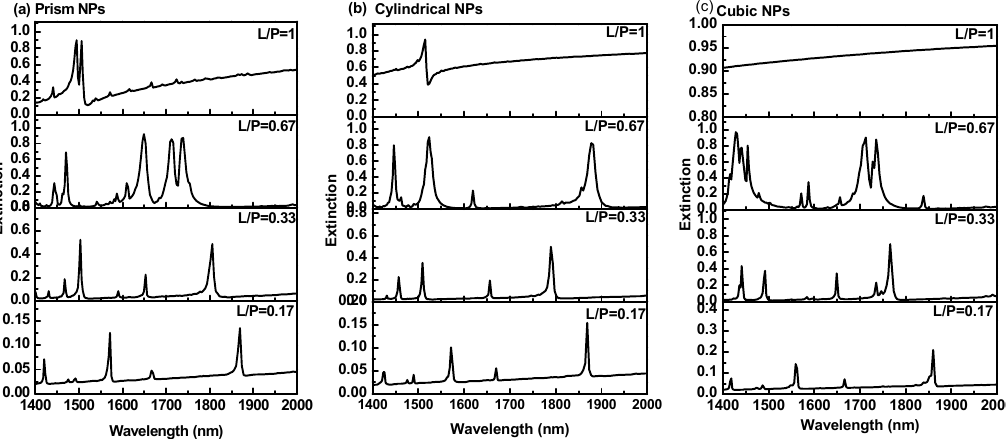
Figure 3. Extinction spectra of hybrid nanostructure with ( a ) prism; ( b ) cylindrical; and ( c ) cubic NPs at different L/P ratios and thickness of 20 nm.